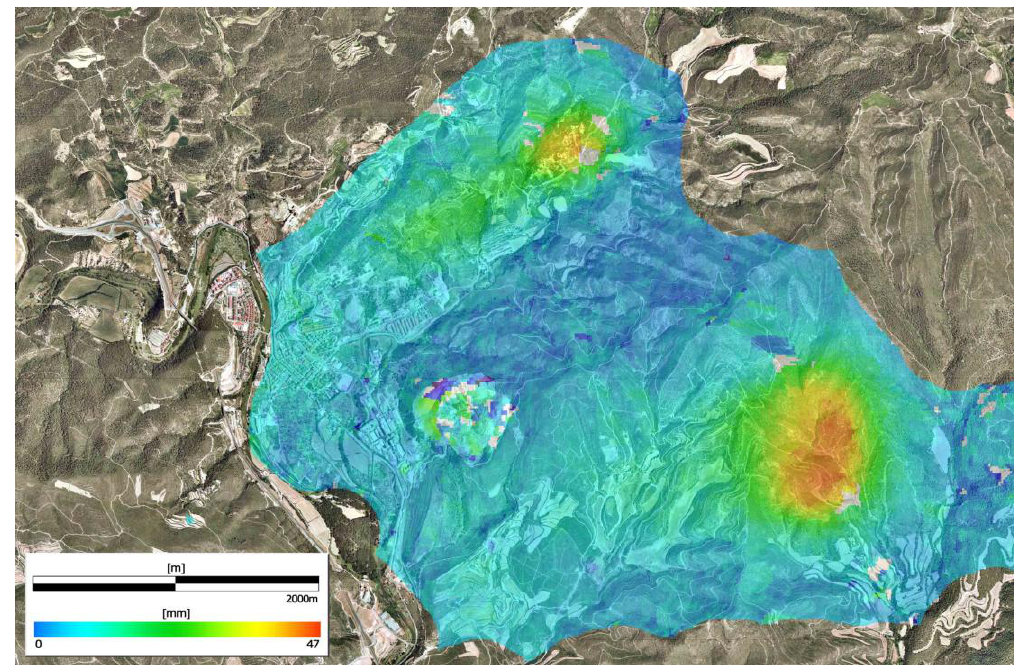
Figure 2. Geocoded displacement map over a mining area located in Catalonia (Spain), which was derived by a standard DInSAR analysis. The map is superimposed over an orthoimage from the Cartographic Institute of